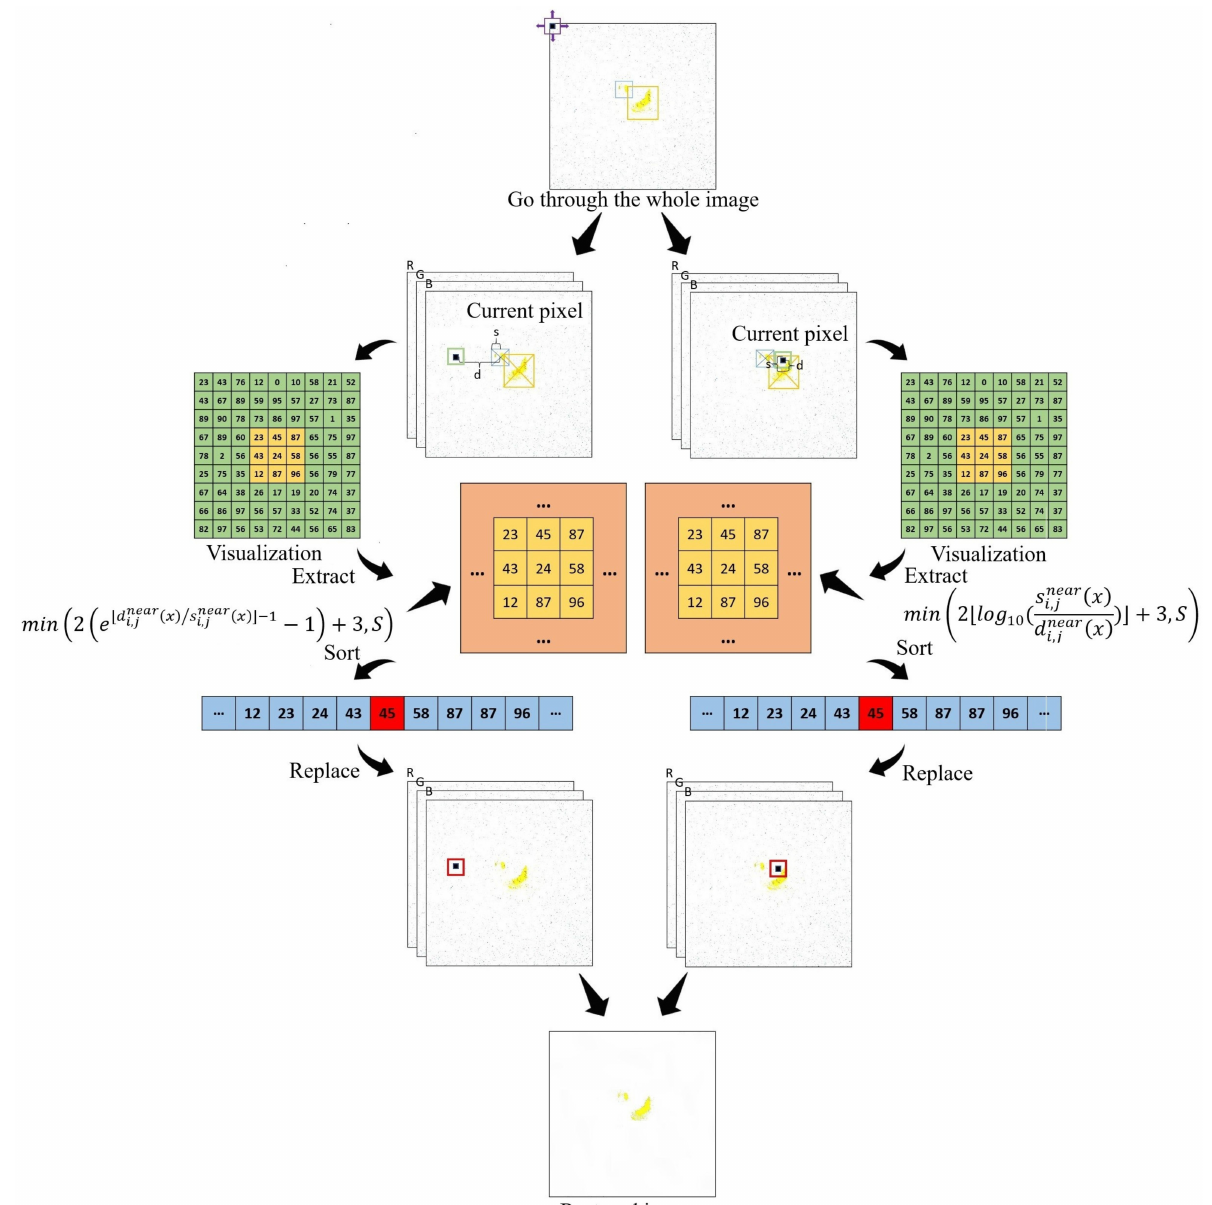
Figure 10. The process of